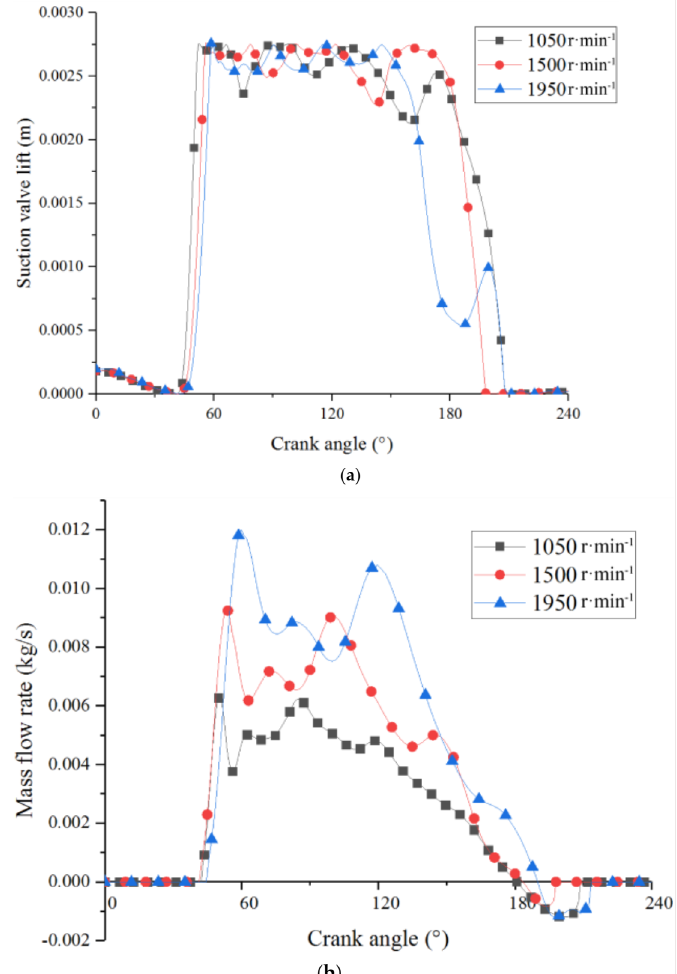
Figure 17. ( a ) The movement of the suction valve at various rotation speeds. ( b ) The mass flow characteristics of the suction valve at various rotation